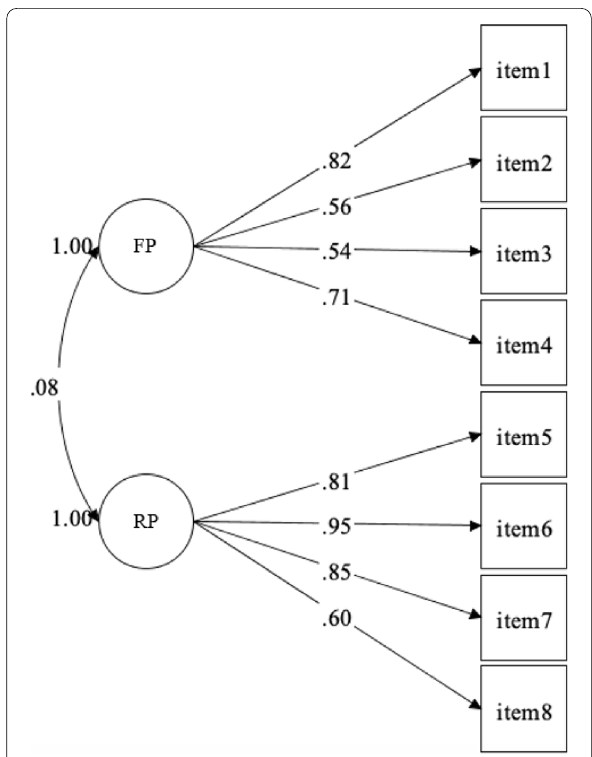
Fig. 1 Confirmatory factor analysis for the items of the Rigid and Flexible Persistence Scale ( n 250). Note. All factor loadings were = statistically significant ( p <